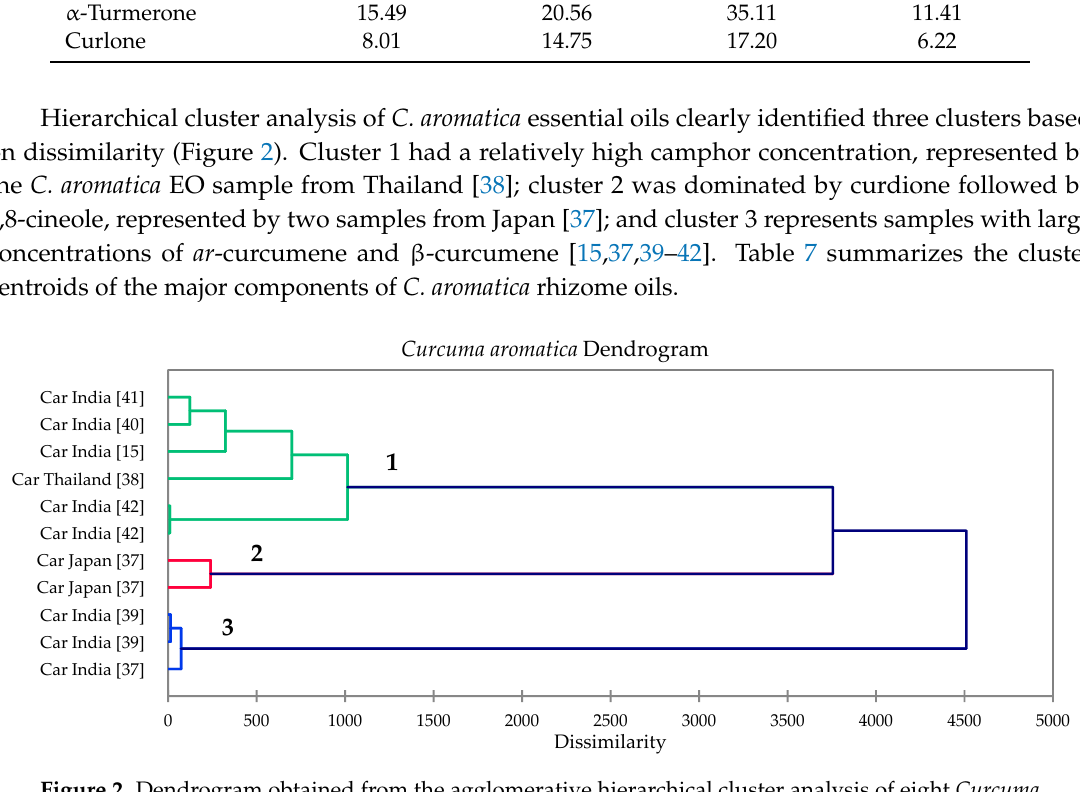
Figure 2. Dendrogram obtained from the agglomerative hierarchical cluster analysis of eight Curcuma aromatica essential oil samples. Table 7. Concentration (%) of centroids used in the cluster analysis of Curcuma aromatica rhizome oils.